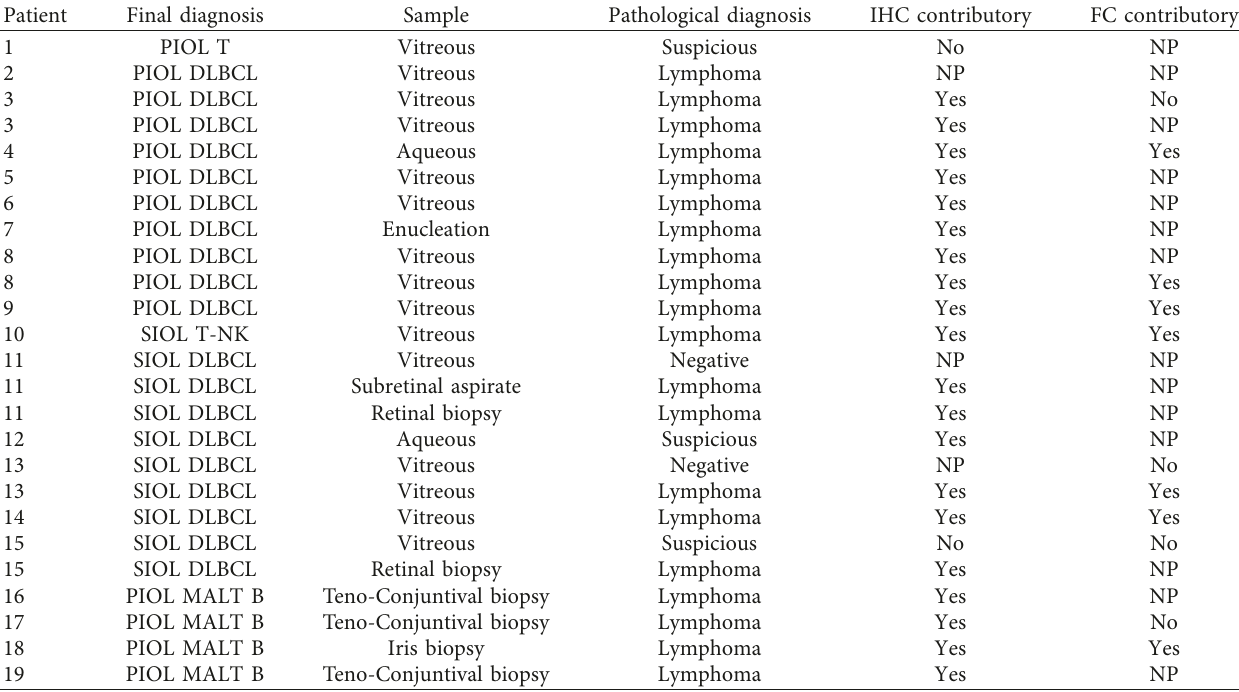
Table 2: Contribution of diagnostic techniques according to final diagnosis and type of specimen in intraocular lymphomas.